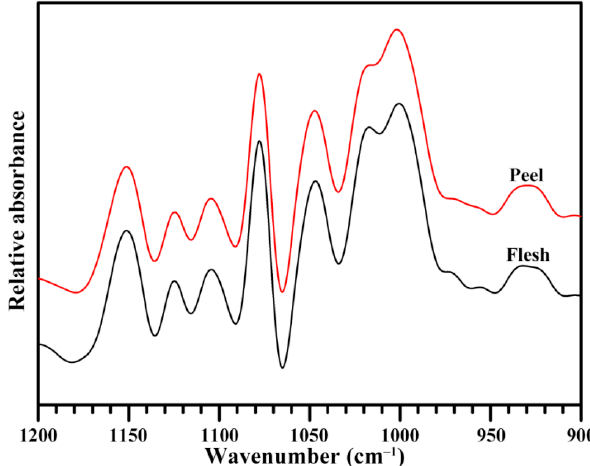
Figure 4. Attenuated total reflectance (ATR)-Fourier transform infrared spectrometer (FTIR) spectra of starches.